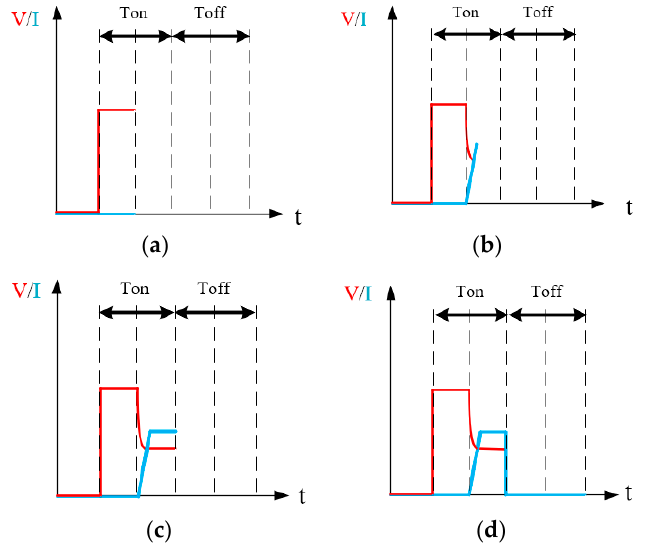
Figure 1. Electrical Spark Discharge Method (discharge success): ( a ) voltage without current; ( b ) discharge start; ( c ) spark discharge occurs; ( d ) discharge off.